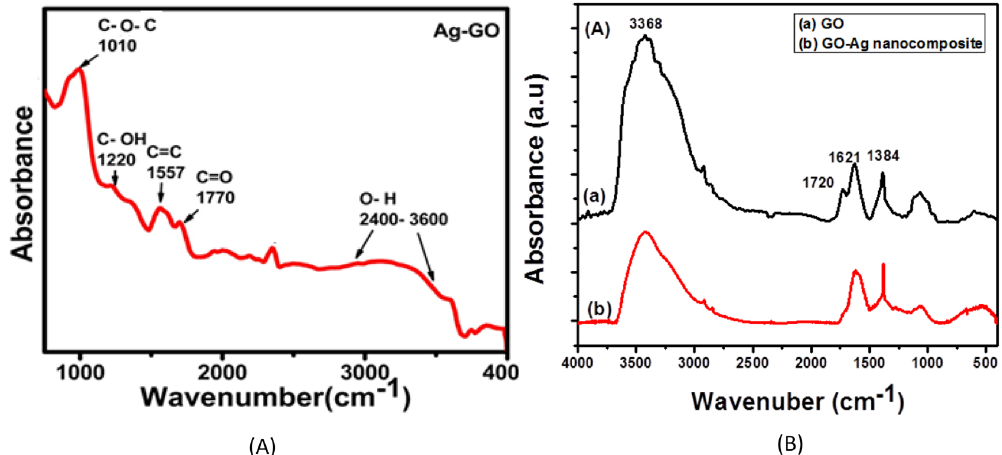
Figure 2. ( A ) FTIR spectrum of Ag–GO sample ( B ) FTIR spectra of GO and Ag–GO reported in Ref. 22 .